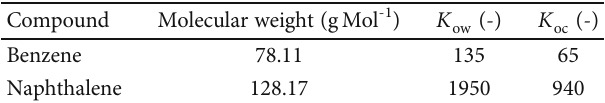
Table 1: Properties of benzene and naphthalene used in this study. K and K are the octanol-water partitioning coe ffi cient and ow oc organic carbon-water partitioning coe ffi cient from Mabey et al. [33],